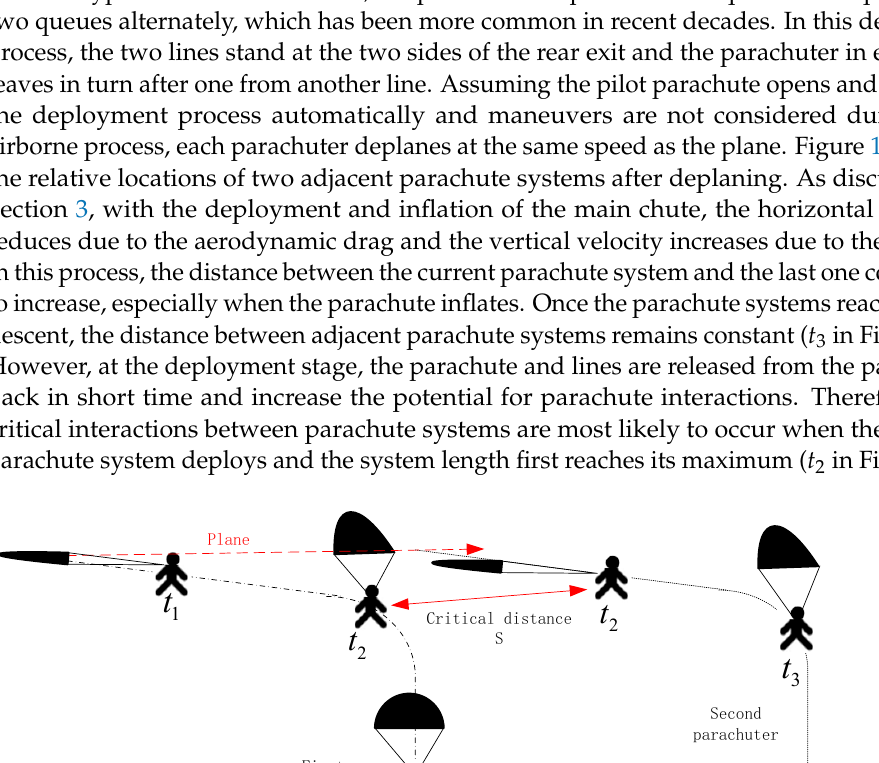
Figure 10. Flight trajectories of parachute systems with different masses.